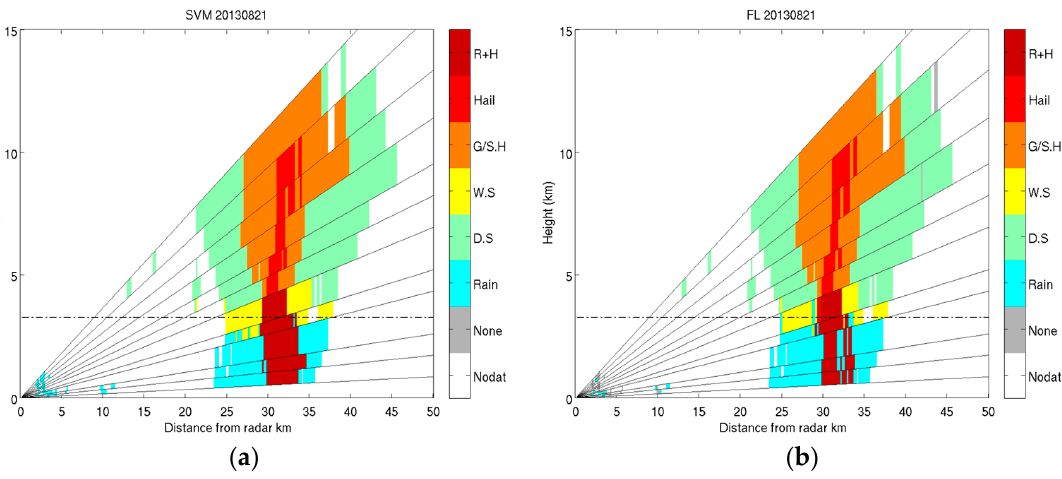
Figure 7. As in of Figure 6, vertical cuts for SVM and FL classifications applied to data gathered at 122° azimuth on 21 August 2013 at 0450 UTC.